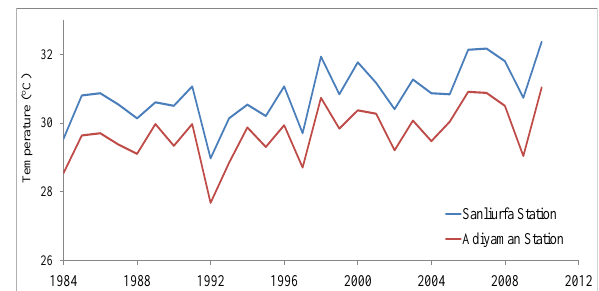
Fig. 5 Annual temperature distribution of Dam Lake and Harran Plain